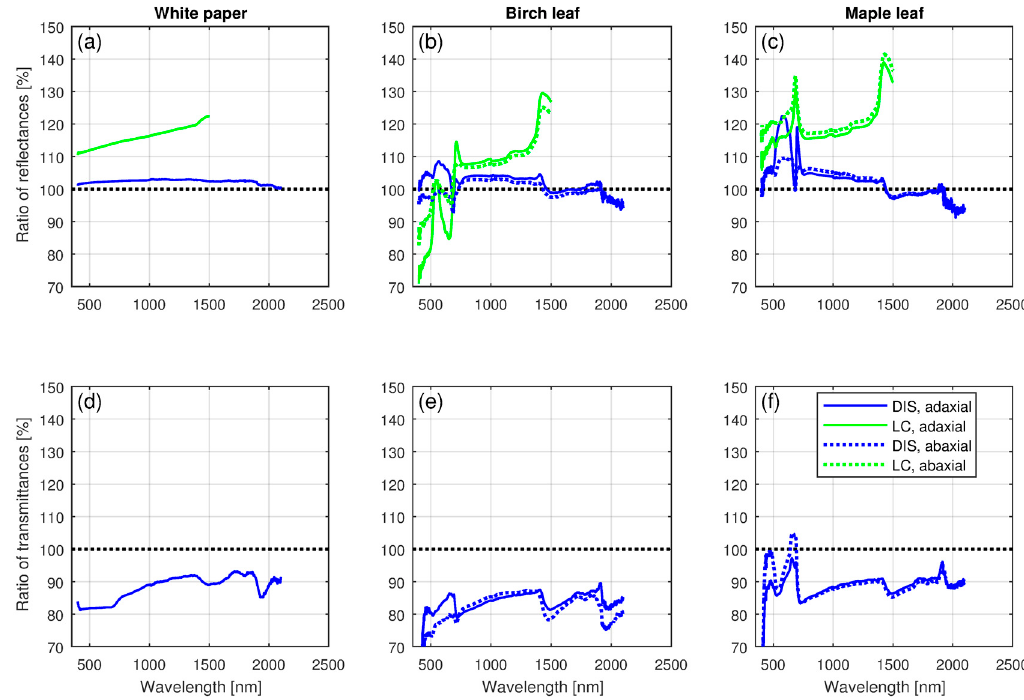
Figure 4. Ratios of mean spectra of white paper, birch leaves, and maple leaves measured with different methods. The y -axis denotes the ratio of double integrating sphere (DIS) or leaf clip (LC) to single integrating sphere (SIS). Upper row ( a – c ): Reflectance; lower row ( d – f ): Transmittance.